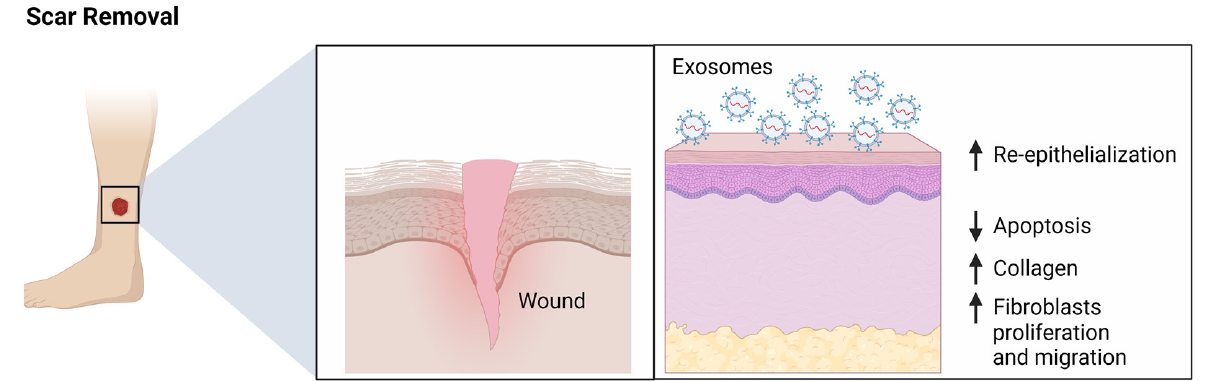
Figure 4. Role of exosomes in the treatment of scars. MSC-derived exosomes from umbilical cords showed enrichment in specific miRNAs, including miR-21, -23a, -125b, and -145. Their application to a mouse skin-defect model reduced fibrosis, resulting in less scarring. Additionally, human umbilical cord-derived exosomes containing miR-21–3p accelerated re-epithelialization, reduced scar widths, and boosted angiogenesis. Thus, MSC-derived exosomes could regulate fibroblasts, collagen deposition, and promote scarless wound healing. Figure was created using Biorender.